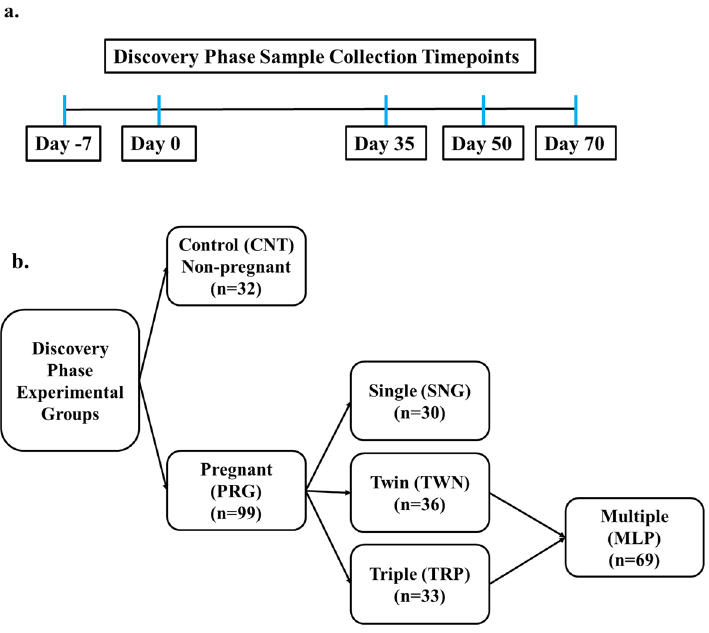
Figure 4. Flowchart showing experimental design and sample collection timepoints during discovery phase. ( a ) Samples were collected at five timepoints during the discovery phase; Day − 7 refers seven days prior to mating ewes and rams, Day 0 refers to the day of mating, Day 35 refers to 35 days after mating, Day 50 refers to 50 days after mating, and Day 70 refers to 70 days after mating. ( b ) Experimental groups during the discovery phase included control ewes (CNT) which were not pregnant (n = 32) and pregnant ewes (PRG) with different litter sizes (n = 99). The PRG group consisted of pregnant ewes that delivered one lamb (SNG), pregnant ewes